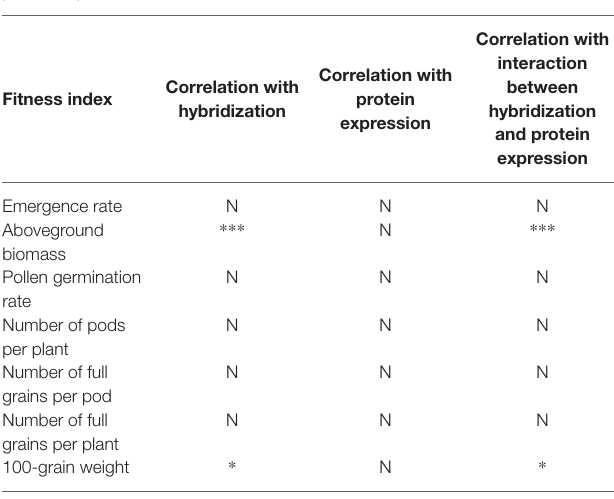
TABLE 5 | Hundred-seed weight of genetically modified, wild soybeans, and hybrid progeny (g).